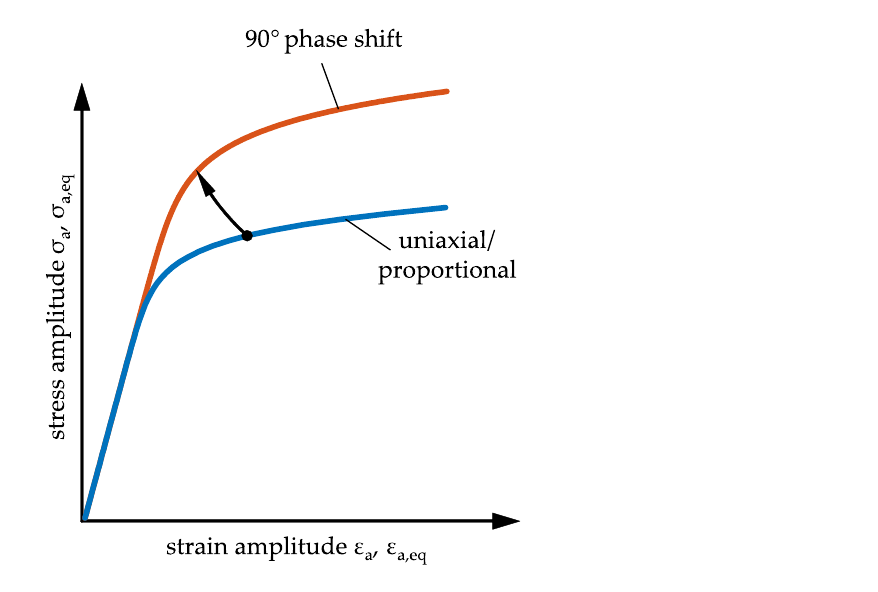
Figure 7. Expected shift of local stress and strain amplitude during nonproportional hardening for notched components.